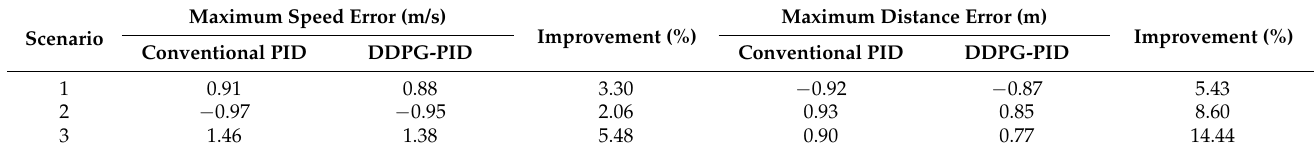
Table 5. Comparison of experimental